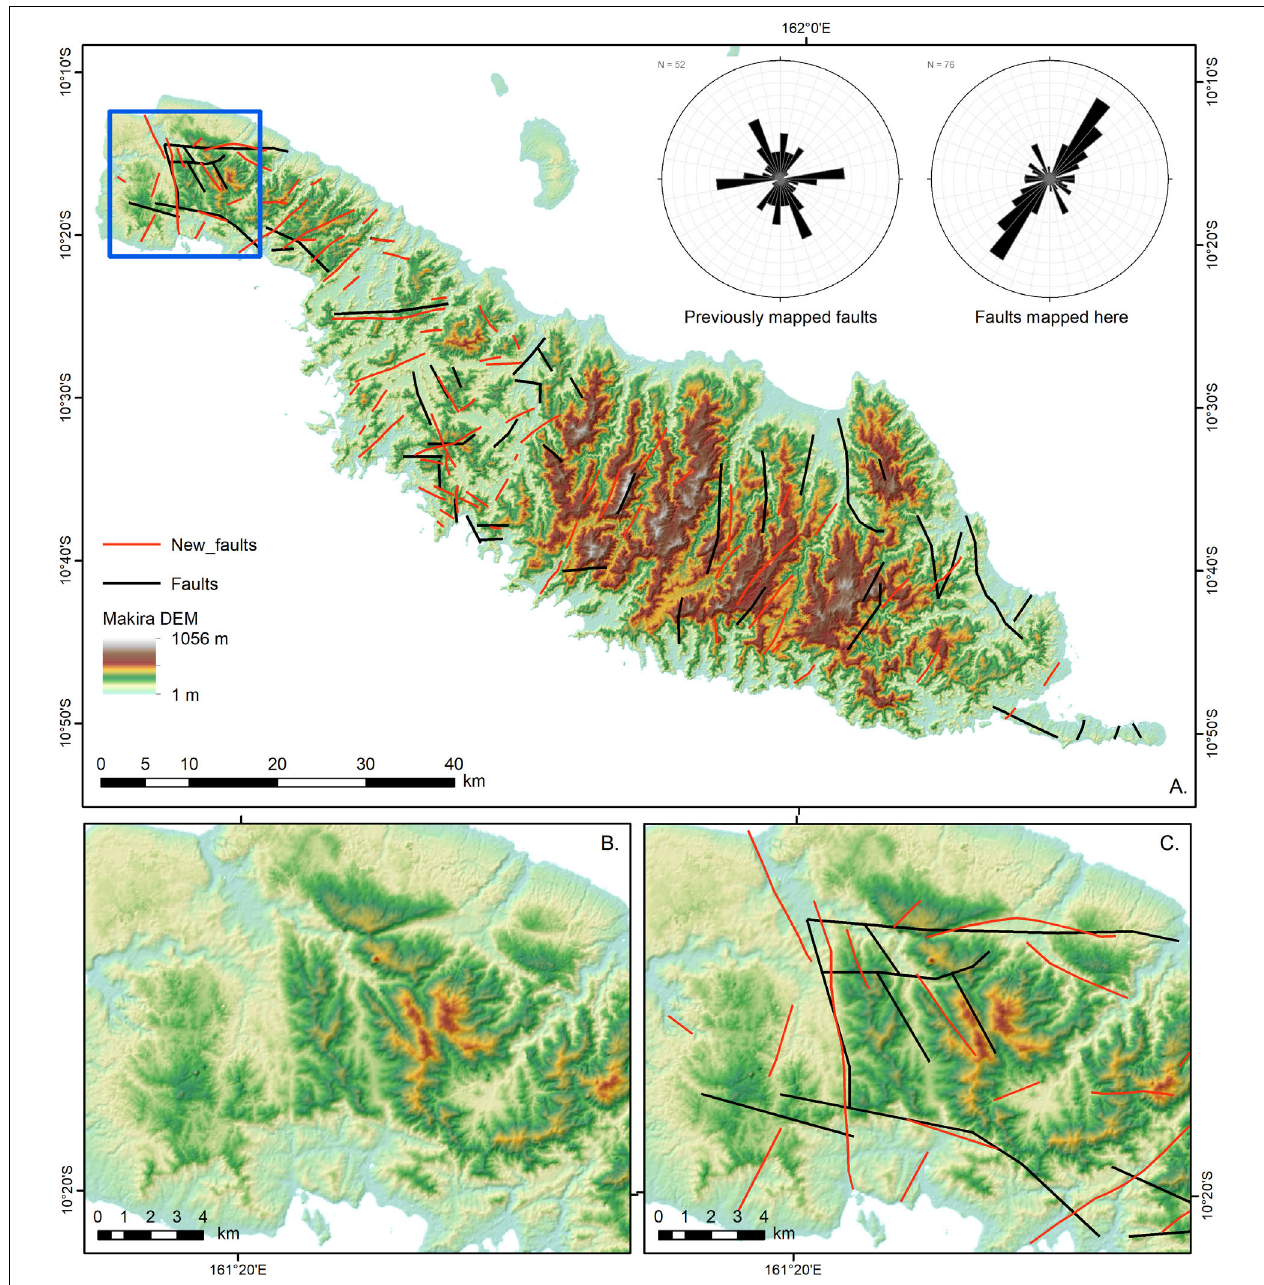
FIGURE 9 | (A) ALOS World 3D 30 m DEM (©JAXA) of Makira showing existing faults from the published mapping data (Department of Geological Surveys, 1969) and inferred topographic lineaments, rose diagrams showing the orientations of both datasets are shown in the top right corner. (B,C) Raw and interpreted DEM for the area shown in the blue box on part (A)